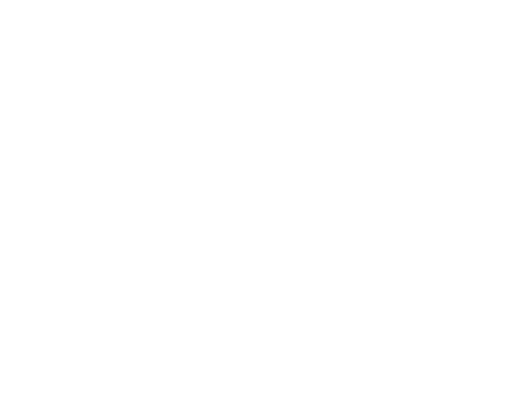
Figure 1. Topographical distribution of the fNIRS recording channels. Twelve probes (5 sources and 7 detectors) were placed, covering the PFC with a probe distance of 25 mm, resulting in a total of 15 channels. The electrodes were positioned at reference point FPz according to the 10/20 international system on each participant’s head.